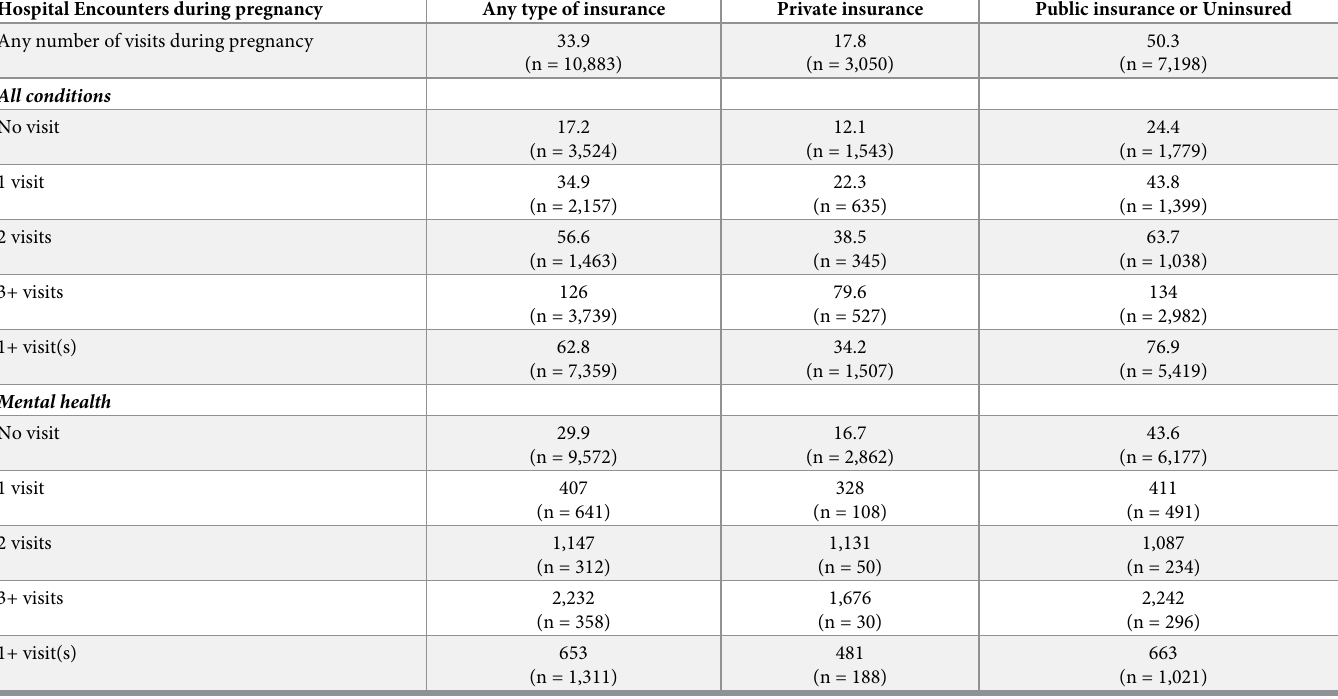
Table 2. Depression rates per 10,000 deliveries and absolute numbers of patients in different data groups based on type of insurance and number of hospital encounters during